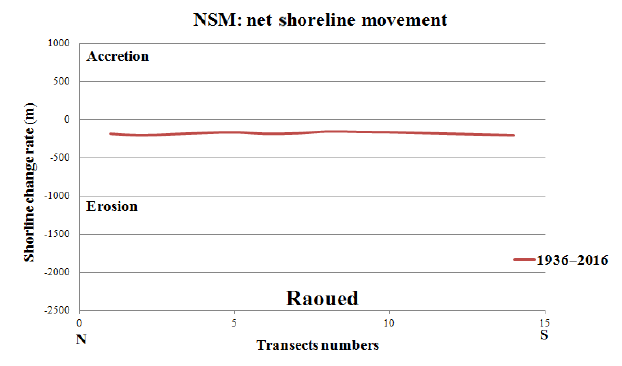
Figure 12. The rates of shoreline changes (MSN) in Raoued.